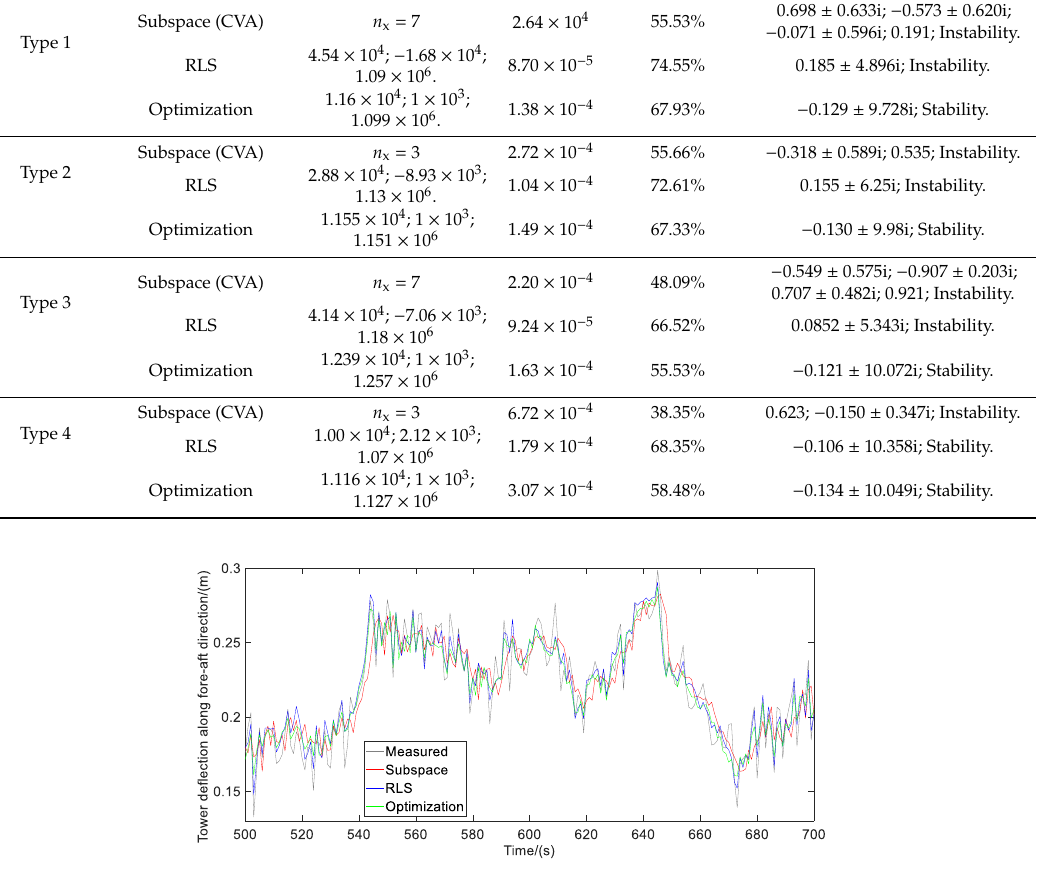
Figure 12. Comparison of tower deflection under scenario Type 1.